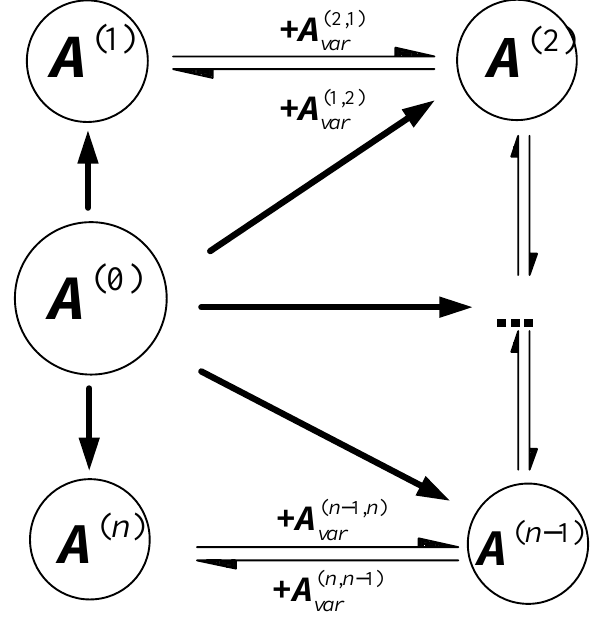
Figure 3. The relationship between the original metamorphic Fig. 3 The relationship between the original metamorphic mechanism and the mechanism in mechanism and the mechanism in any